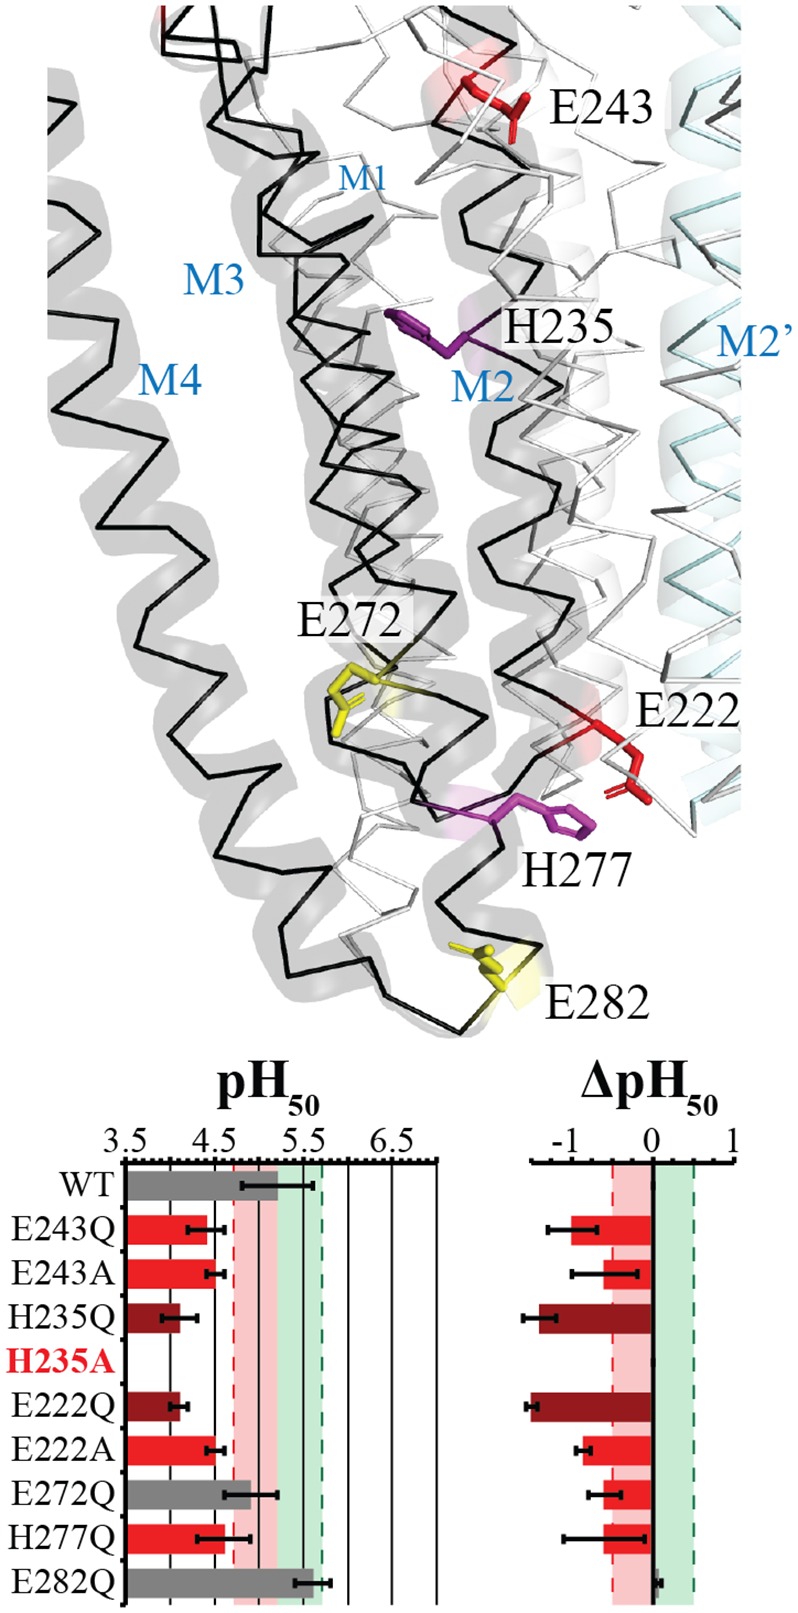
TMD residues decrease sensitivity.Stick representation of the evaluated Glu and His residues are labeled. Glu residues are color coded based upon effect, with residues in red producing a significant decrease in pH50, and in yellow, an insignificant or weak effect, whereas the dark purple and magenta for His residues are synonymous to the red of Glu residues. The main subunit is shown in black, with ribbon and cartoon representation with the α-helices labeled, whereas neighboring subunits are represented in white ribbon. The M2 α-helix of the neighboring subunit (labeled M2ʹ) is also highlighted in cyan and in cartoon representation. A table of the pH50 and ΔpH50 is shown below with mean values ± standard deviation for evaluated mutants with recorded values noted in S1 Table. Light red and green zones with dashed lines represent the respective ½ log decrease and increase from Wt. Values outside this region are color coded for ease of interpretation, with red and darker red as significant decreases and a decrease of greater significance, respectively. TMD, transmembrane domain; Wt, wild-type.